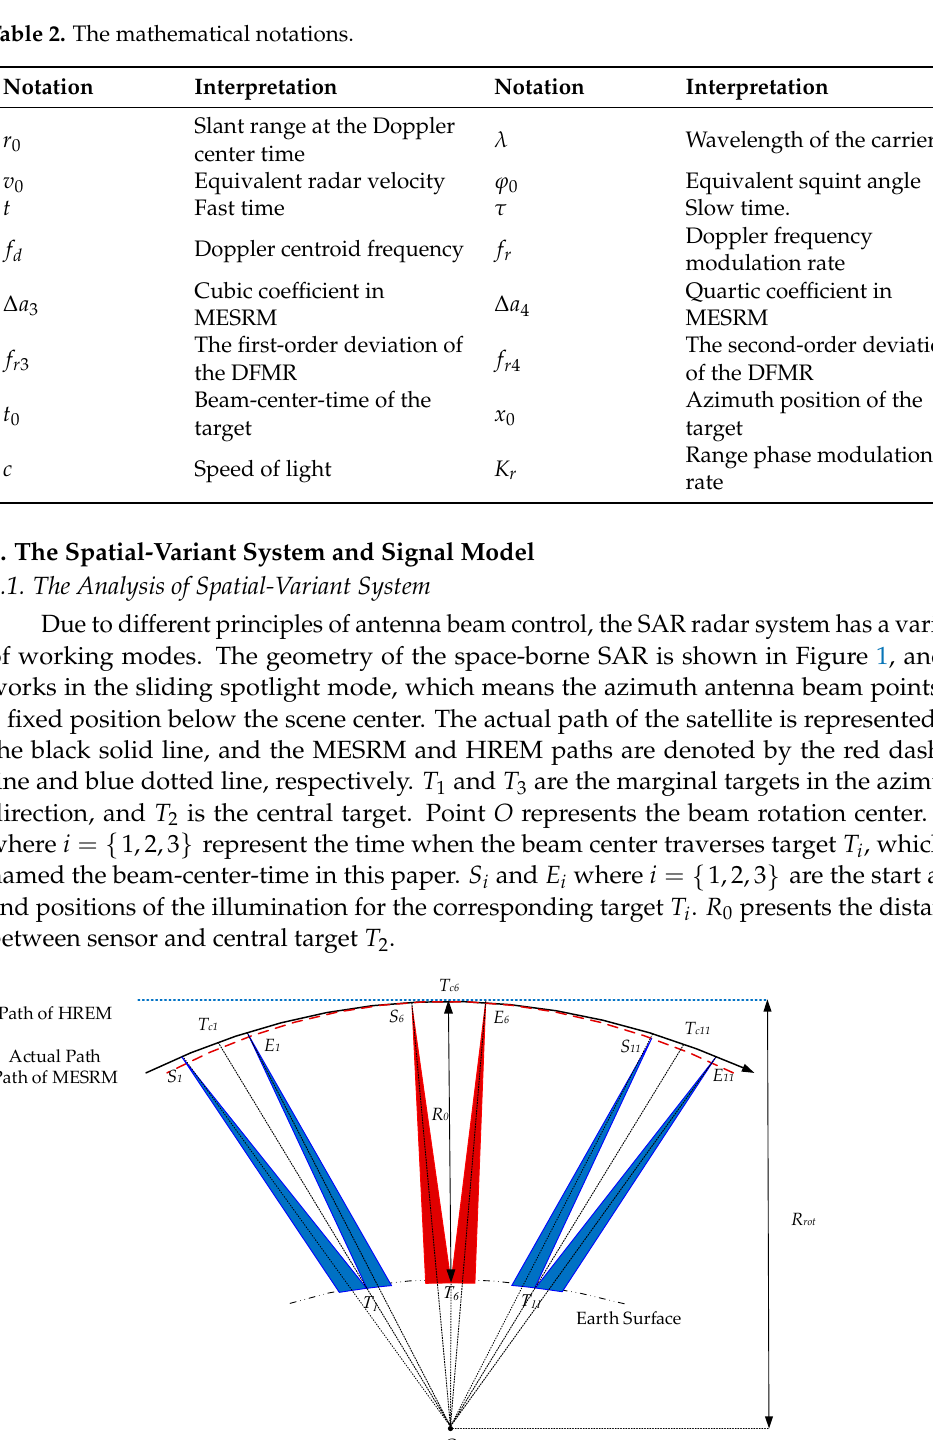
Table 2. The mathematical notations.